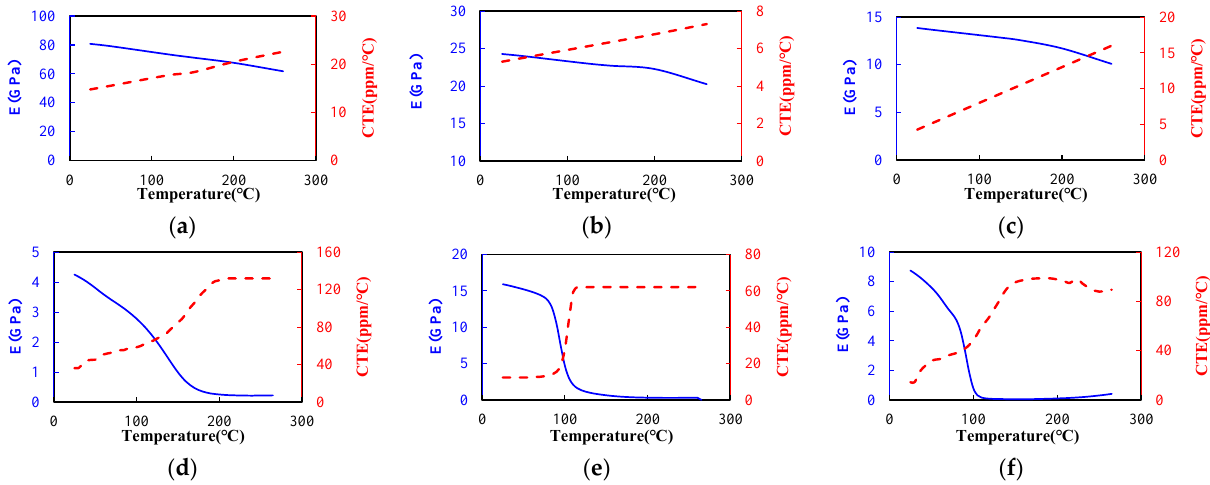
Figure 7. Temperature-dependent Young’s modulus (solid line) and CTE (dashed line) of the components: ( a ) Cu; ( b ) core material; ( c ) PP; ( d ) solder mask; ( e ) EMC; ( f ) underfill.